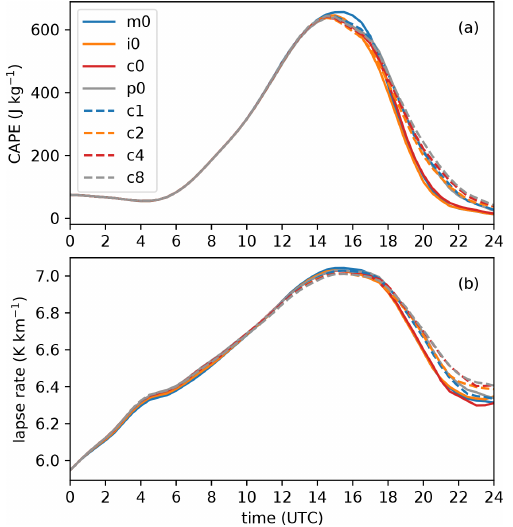
Figure 7. Domain-averaged convective available potential energy (CAPE; a ) and 700–500hPa lapse rate (b) on 11 June